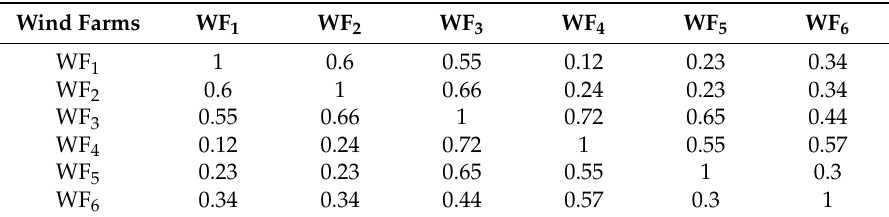
Table 3. The correlation coefficients among wind speeds.